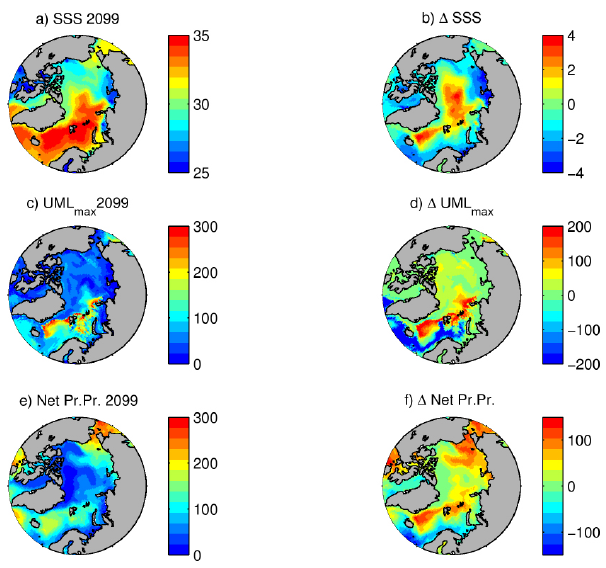
Fig. 3. Arctic Ocean surface salinity (a, b) , maximum upper mixed layer depth (UML) (c, d) in m, net primary production (a–c) in gCm − 2 yr − 1 . The first column shows values for year 2099; the sec- ond column shows deviation between year 2099 and year